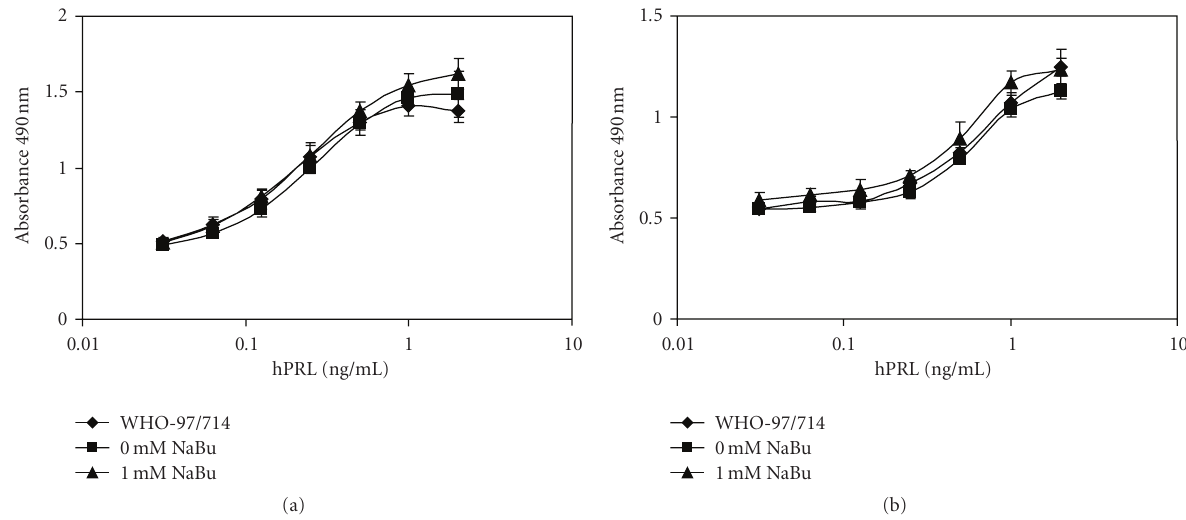
Figure 8: Bioactivity of purified hPRL obtained from CHO cells treated or not with NaBu, determined via (a) Nb2 or (b) Ba/F3-LLP cell assays against the International Standard of Recombinant hPRL (WHO 97/714). Values are the mean of two independent